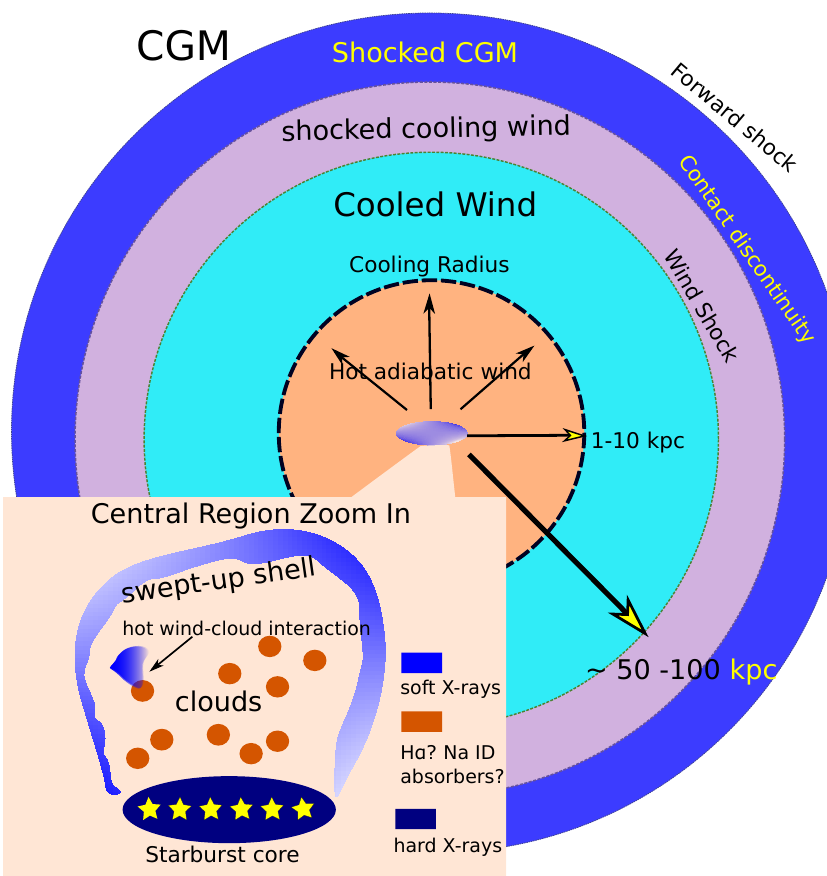
Figure 4. The schematic of the evolution of a hot wind to a large distance of 100kpc. The hot wind ∼ launched from the starburst region (host) cools radiatively above the cooling radius at 1–10kpc, then ∼ the wind and the surrounding CGM are both shocked. Warm and cool clouds may be produced in the cooled wind by thermal instabilities, and advected to the halo. Please note that in this scenario the interaction between the hot wind and the ambient medium only provides mass-loading and increases β . The realistic process of the ISM and hot wind interaction needs to be further studied. The central region of the system is zoomed in (see the lower left schematic). The starburst region where the hot wind is launched contributes to the hard X-ray emission, while the interaction between the hot wind and clouds and the large-scale ISM contributes to the soft X-ray emission. If the entrained clouds are cold/cool/warm ( 10 2 –10 4 K), the acceleration of clouds by the hot wind may explain the association ∼ between some soft X-rays, H α or molecular emission. However, it is still unclear whether clouds can be accelerated by the ram pressure of the hot wind to the observed velocities, or they may be completely shredded before fully accelerated due to hydrodynamic instabilities. Magnetic fields may be important to accelerating the entrained clouds. Figure modified from Thompson et al. [186] and Cooper et al.